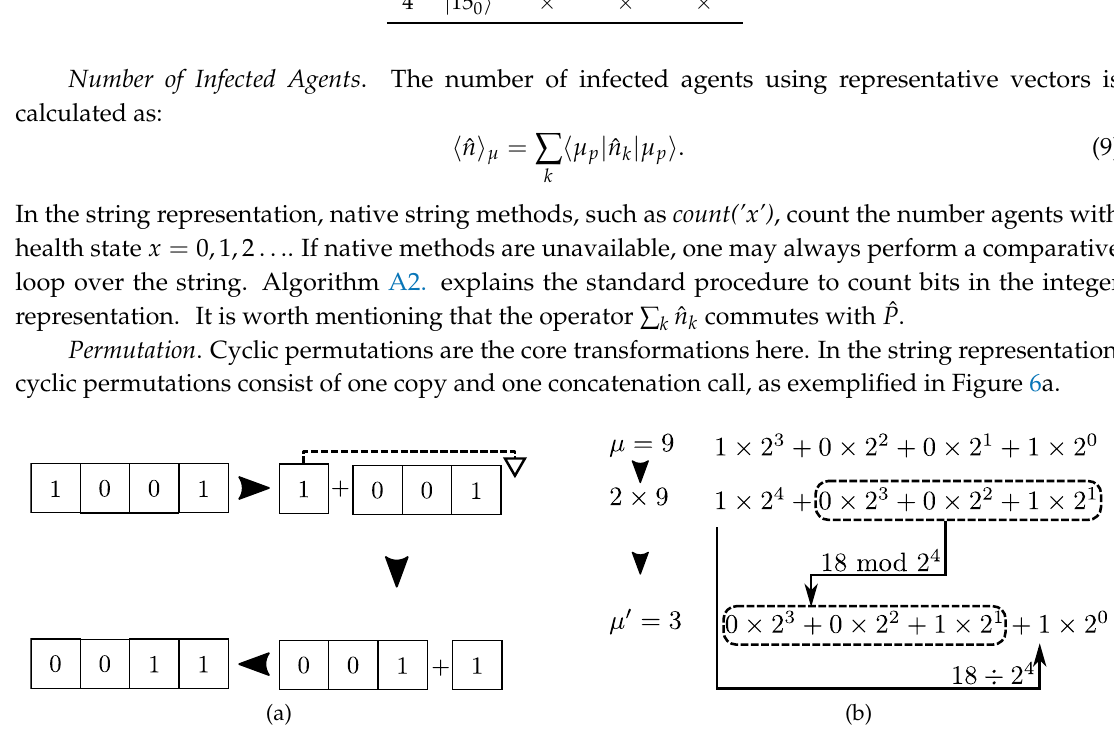
Figure 6. Cyclic permutation for configuration µ = 9 with N = 4. ( a ) String representation executes one copy and one concatenation operation; ( b ) integer representation requires both integer division and modulo operation by 2 N